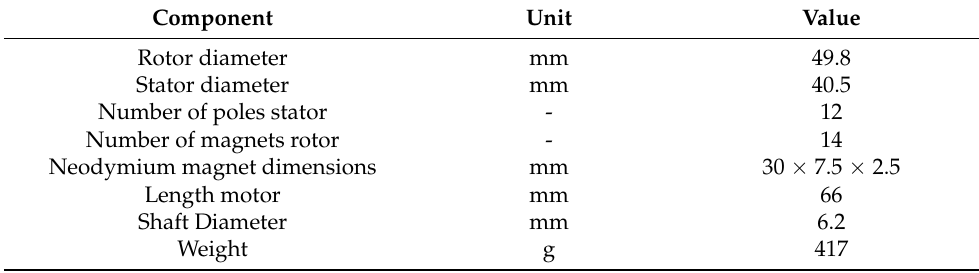
Table 4. BLDC motor characteristics.